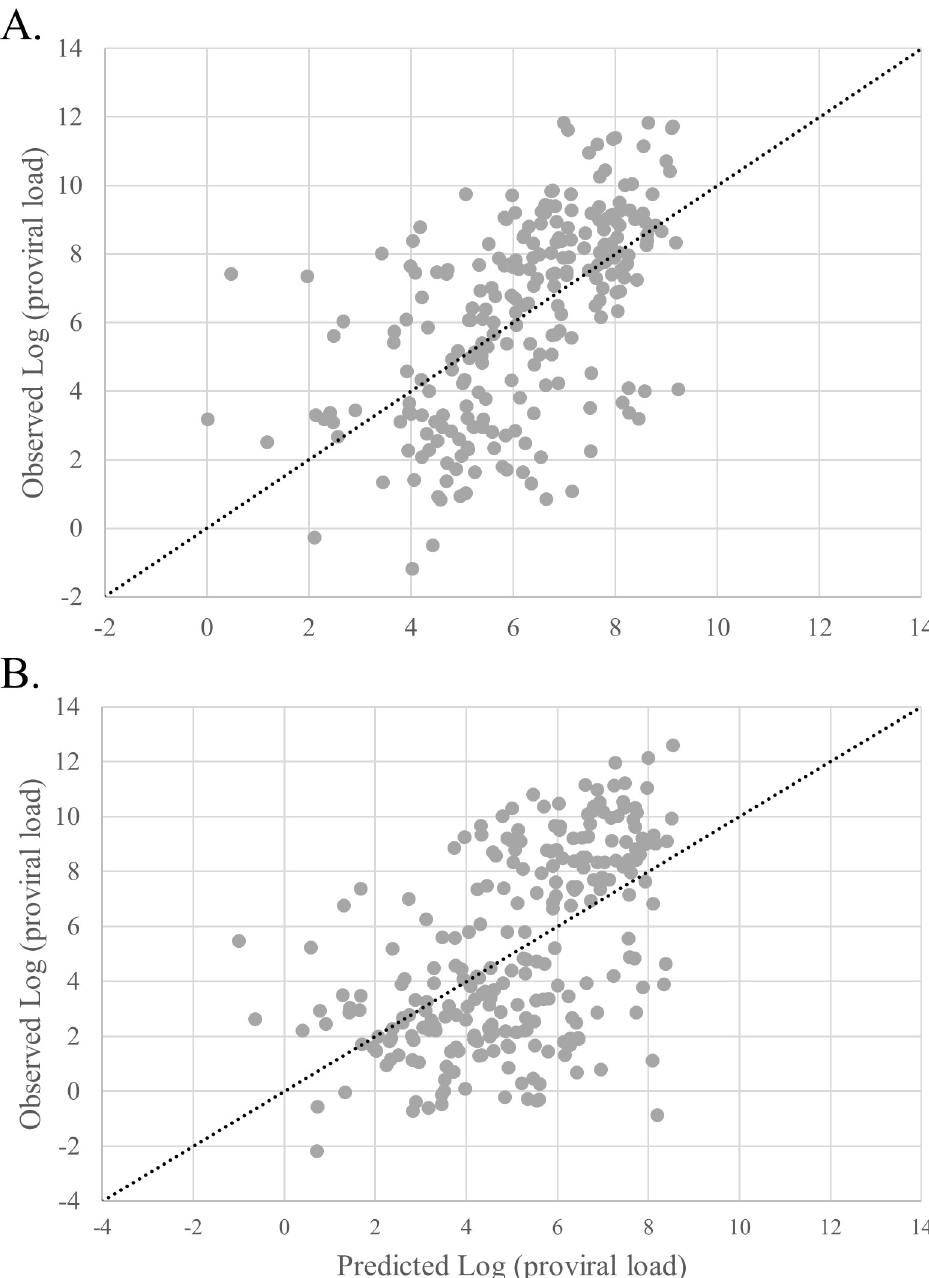
Fig 5. Relationship between observed and predicted logarithm of the proviral load. (A) HTLV-1 samples (N = 246) were plotted by their observed log (PVL) and predicted log (PVL). The linear curve x = y represents the estimated perfect correlation. (B) HTLV-2 samples (N = 245) were plotted by their observed log (PVL) and predicted log (PVL). The linear curve x = y represents the estimated perfect